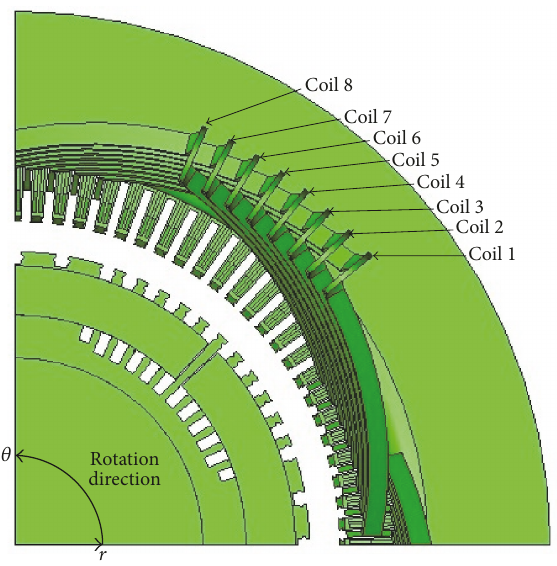
Figure 6: Numbering of phase A